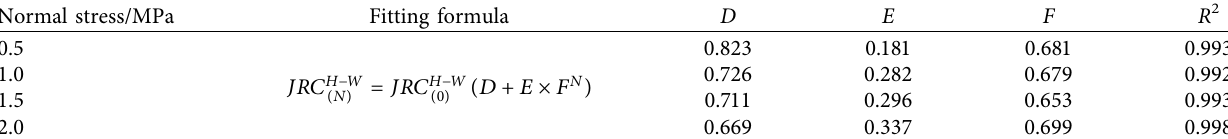
Table 3: Fitting formula and parameter statistics of JRC with heat-wet cycles. Normal stress/MPa